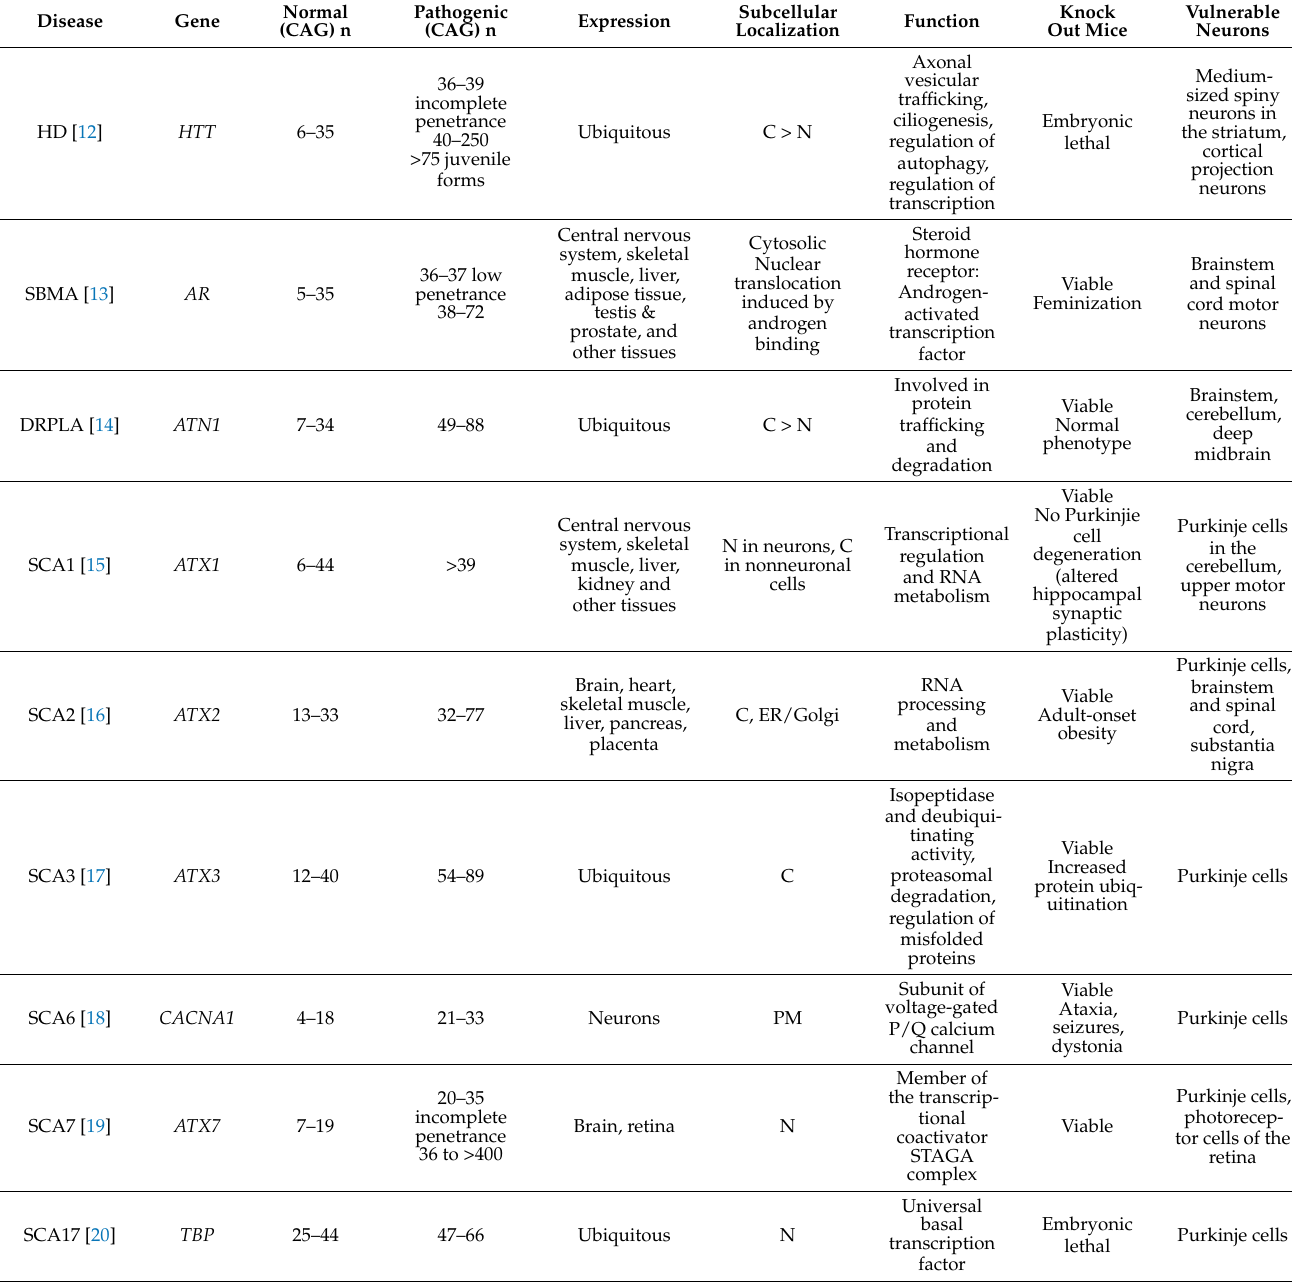
Table 1. Polyglutamine diseases at a